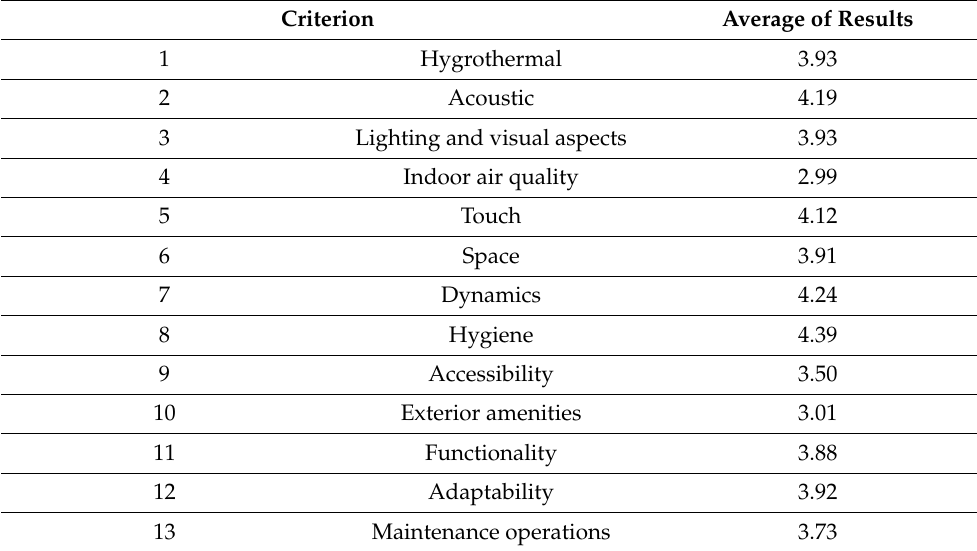
Table 4. General average results from the